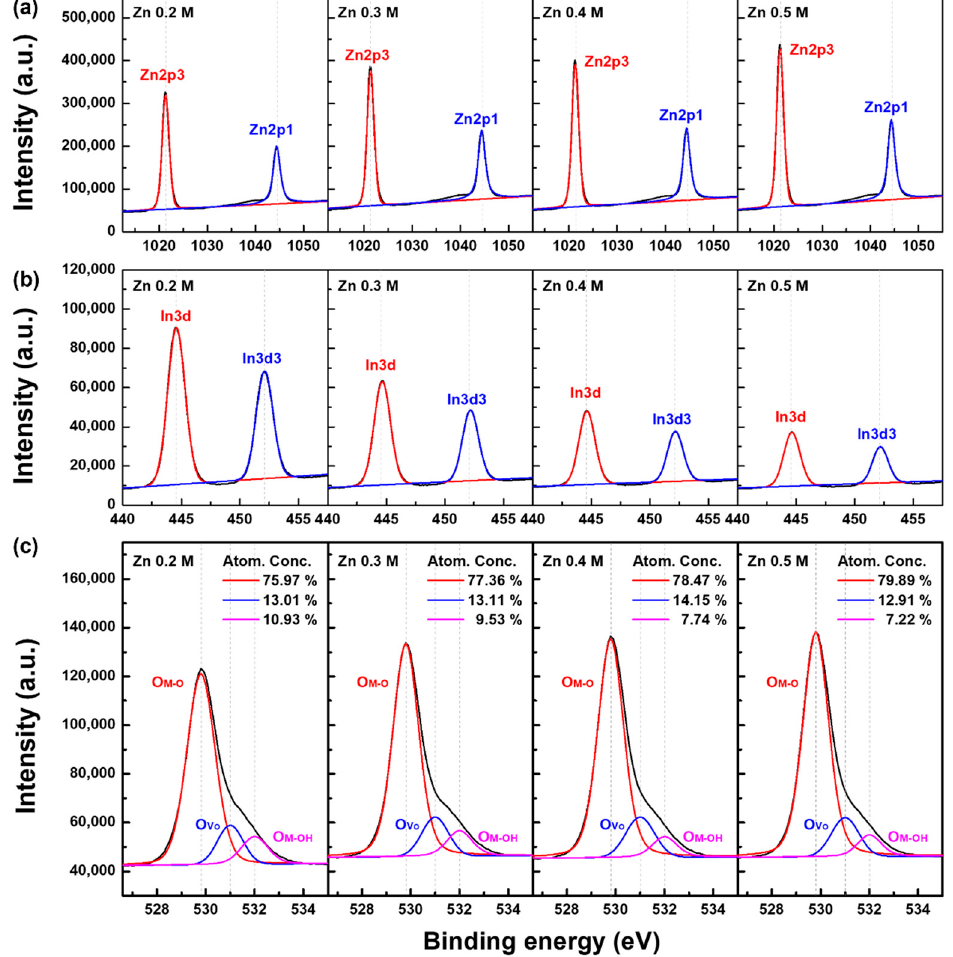
Figure 4. XPS results for stoichiometric characterization with respect to the Zn molarity. ( a ) Zn 2p, ( b ) In 3d, and ( c ) O 1s peak analysis of a -IZO films. The bonding energies of 529.8, 531.0, and 532.0 eV suggest M-O, oxygen vacancy (V O ), and M-OH bond, respectively.